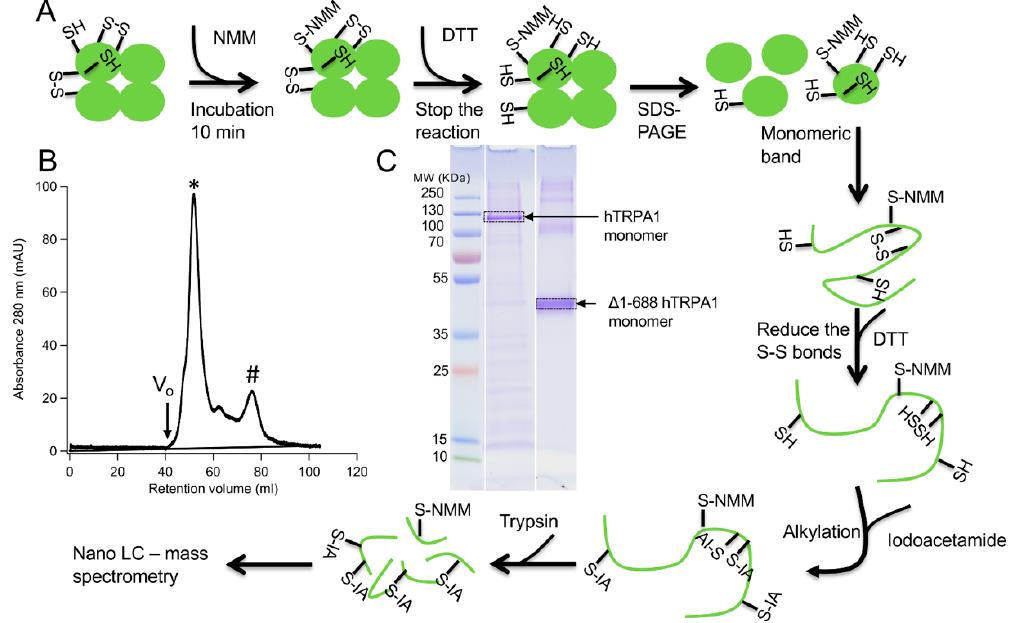
Figure 1. Schematic illustration of steps in the preparation of human transient receptor potential A1 (hTRPA1) proteins for the mass spectrometry analysis. ( A ) The fate of different types of cysteine residues is shown, including modification of free thiols with N-methylmaleimide (NMM), denaturation, reduction of disulphide bonds with dithiothreitol (DTT), iodoacetamide (IA) alkylation of thiols not modified by NMM, and enzymatic digestion. ( B ) Size exclusion chromatogram of the hTRPA1 sample used in the NMM labeling shows that it mainly eluted in a peak corresponding to the tetramer (*) and only a small fraction eluted as a monomer (#). V o indicate void volume. ( C ) Coomassie stained SDS polyacrylamide gel of hTRPA1 and Δ 1-688 hTRPA1. Marked bands are corresponding to monomers of hTRPA1 proteins and were excised from the gel for further reduction and labeling by IA.